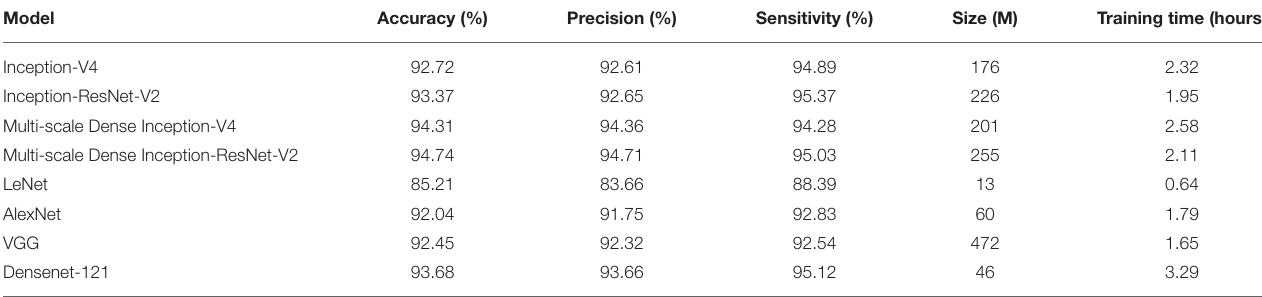
TABLE 3 | Comparison of different models.